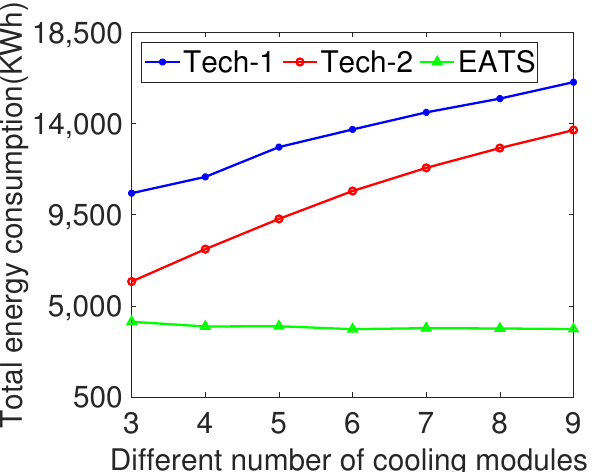
Figure 12. Comparison of total energy consumption with different numbers of cooling modules for Alibaba cluster